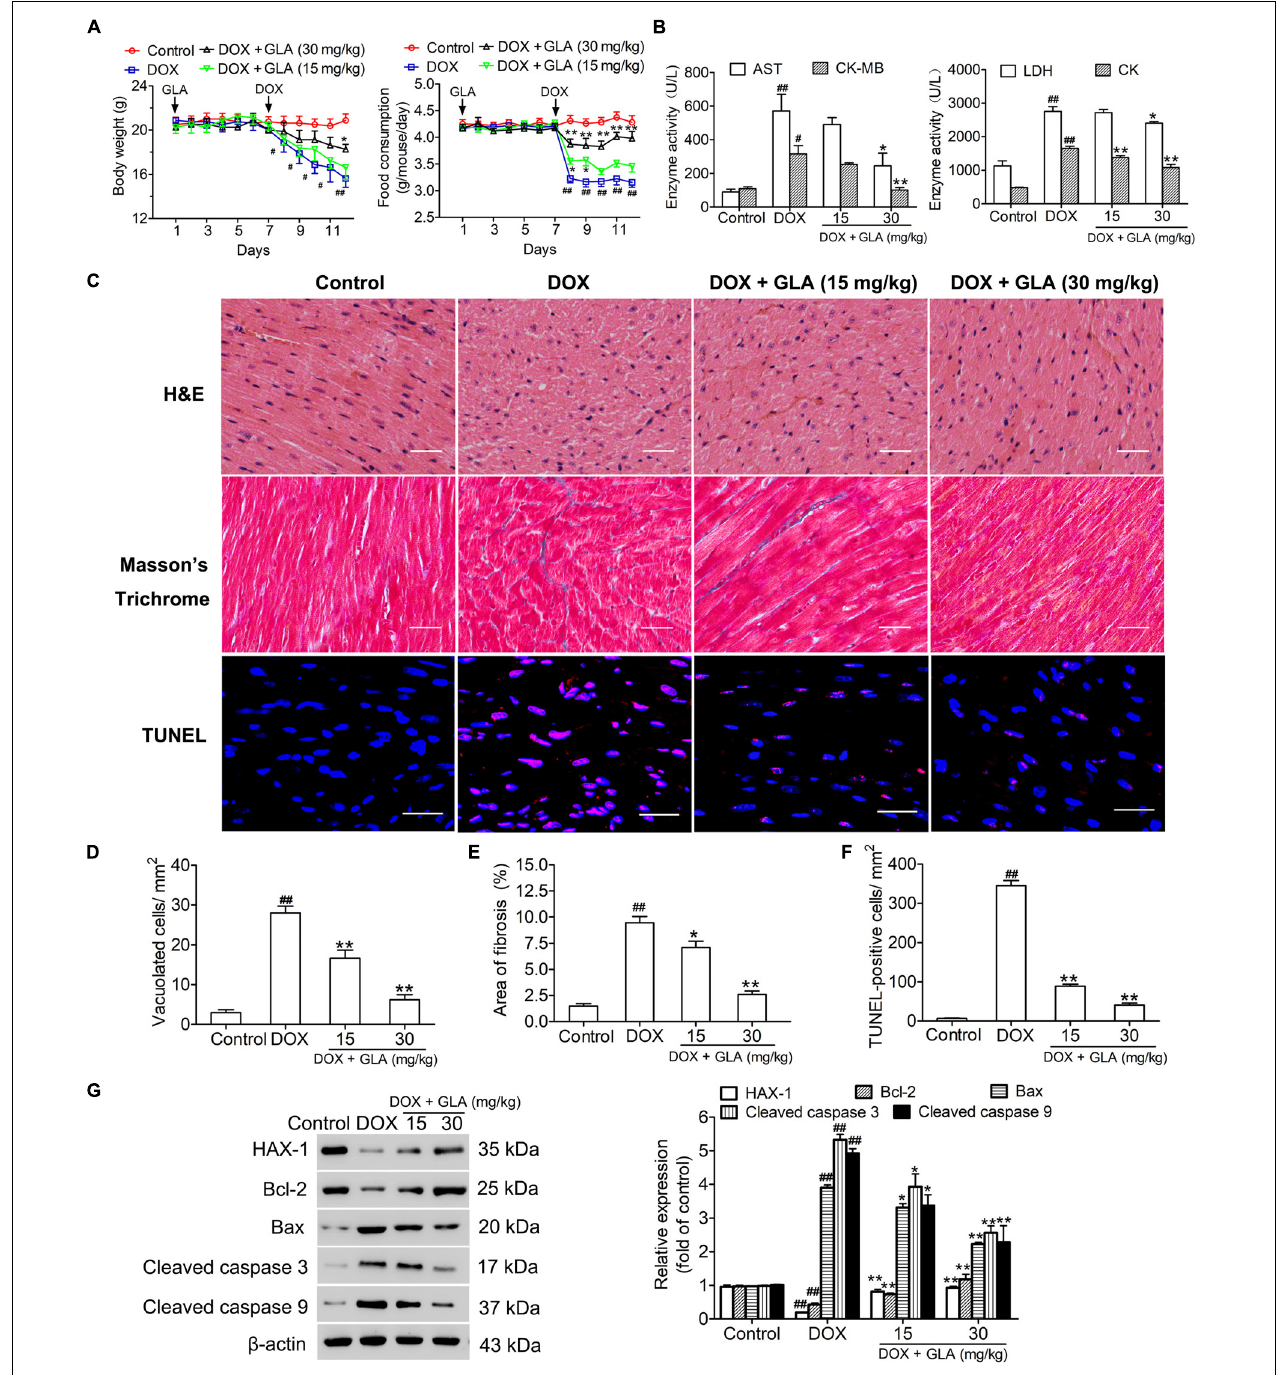
FIGURE 1 | Glabridin (GLA) prevents doxorubicin (DOX)-induced cardiotoxicity in mice. A single dose of DOX (20 mg/kg) was intraperitoneally injected into the C57BL/6 mice to induce acute cardiotoxicity. GLA (15 and 30 mg/kg) or vehicle was intragastrically administered once daily for 12 days, starting 7 days before DOX injection. (A) Changes in body weights and food intake ( n = 10). (B) Serum levels of AST, CK-MB, LDH, and CK ( n = 10). (C) Histological assessment of hearts ( n = 10). Hematoxylin and eosin (H&E) was performed to evaluate myocardial vacuolization. Scale bars, 50 µ m. Masson staining was performed to evaluate myocardial fibrosis. Scale bars, 50 µ m. TUNEL assay was performed to assess the cardiomyocytes apoptosis. Scale bars, 20 µ m. (D) Quantitative result of vacuolated cells. (E) Quantitative result of myocardial fibrosis area ( n = 10). (F) Quantitative result of TUNEL-positive cells ( n = 10). (G) HAX-1, Bcl-2, Bax, cleaved caspase-3 and cleaved caspase-9 were determined by Western blot ( n = 10). The values are presented as the mean ± SEM. # P < 0.05, ## P < 0.01 vs. control, ∗ P < 0.05, ∗∗ P < 0.01 vs. DOX.